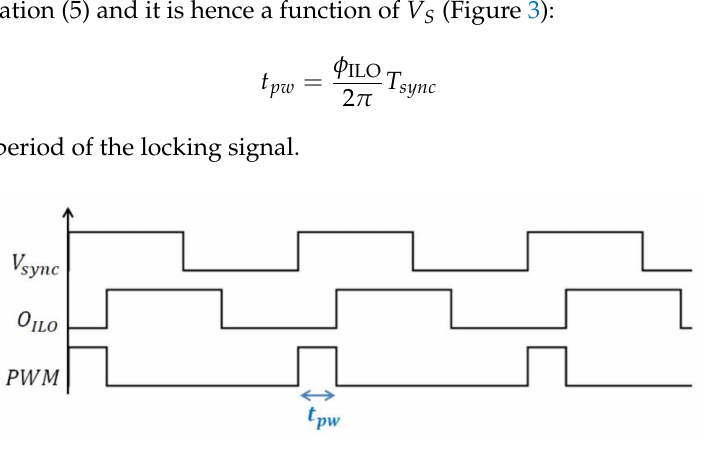
Figure 3. Representation of the output PWM